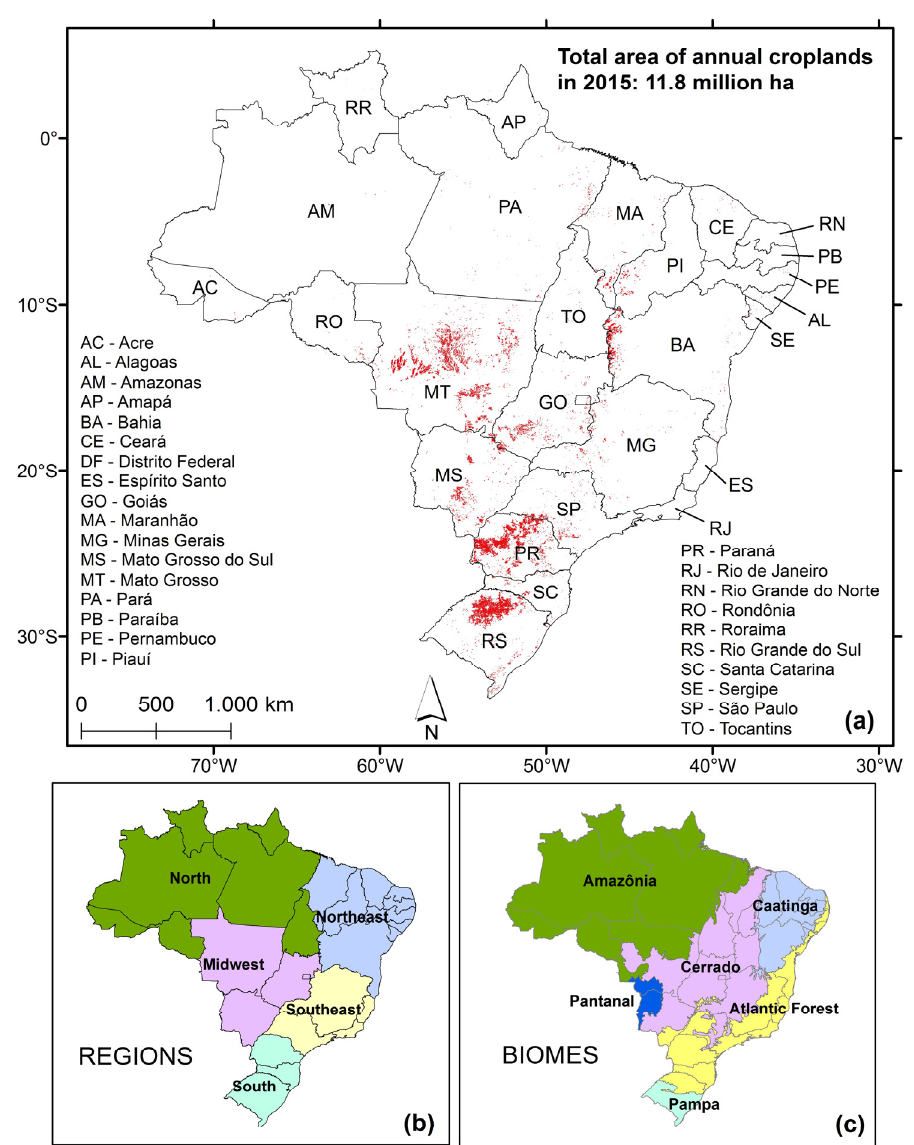
Figure 11. Map of annual croplands in Brazil, derived from the PROBA-V 1 km mosaic ( a) . Inset maps correspond to the five major regions of Brazil ( b ) and the six Brazilian biomes ( c ).